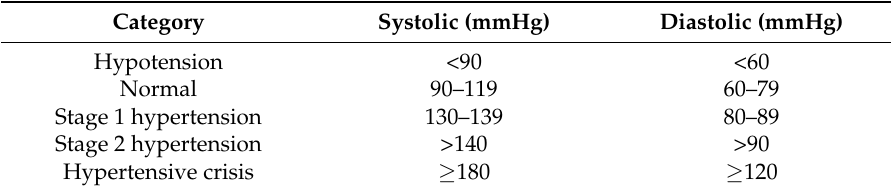
Table 3. Systolic and diastolic blood pressure risk